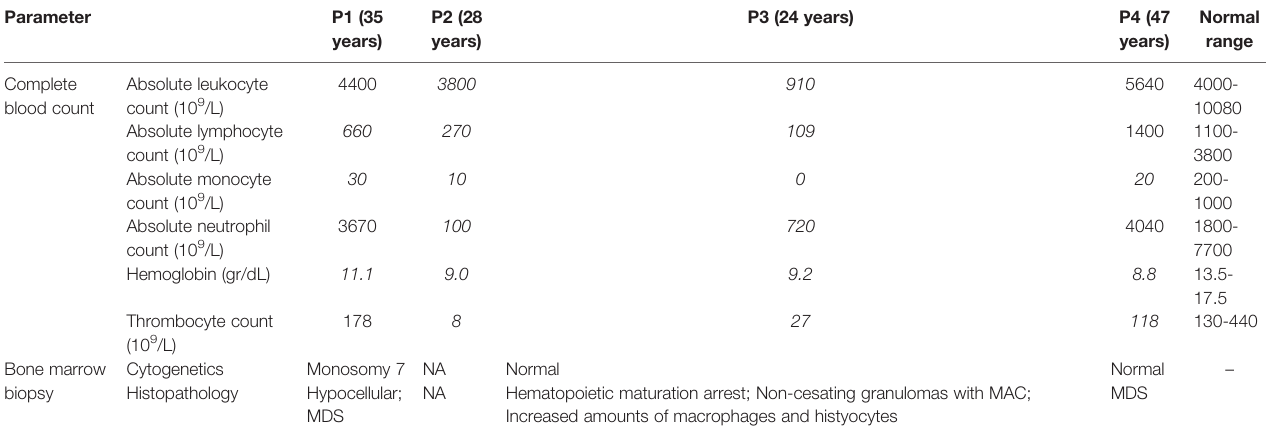
TABLE 2 | Hematologic workup of patients with GATA2 de fi